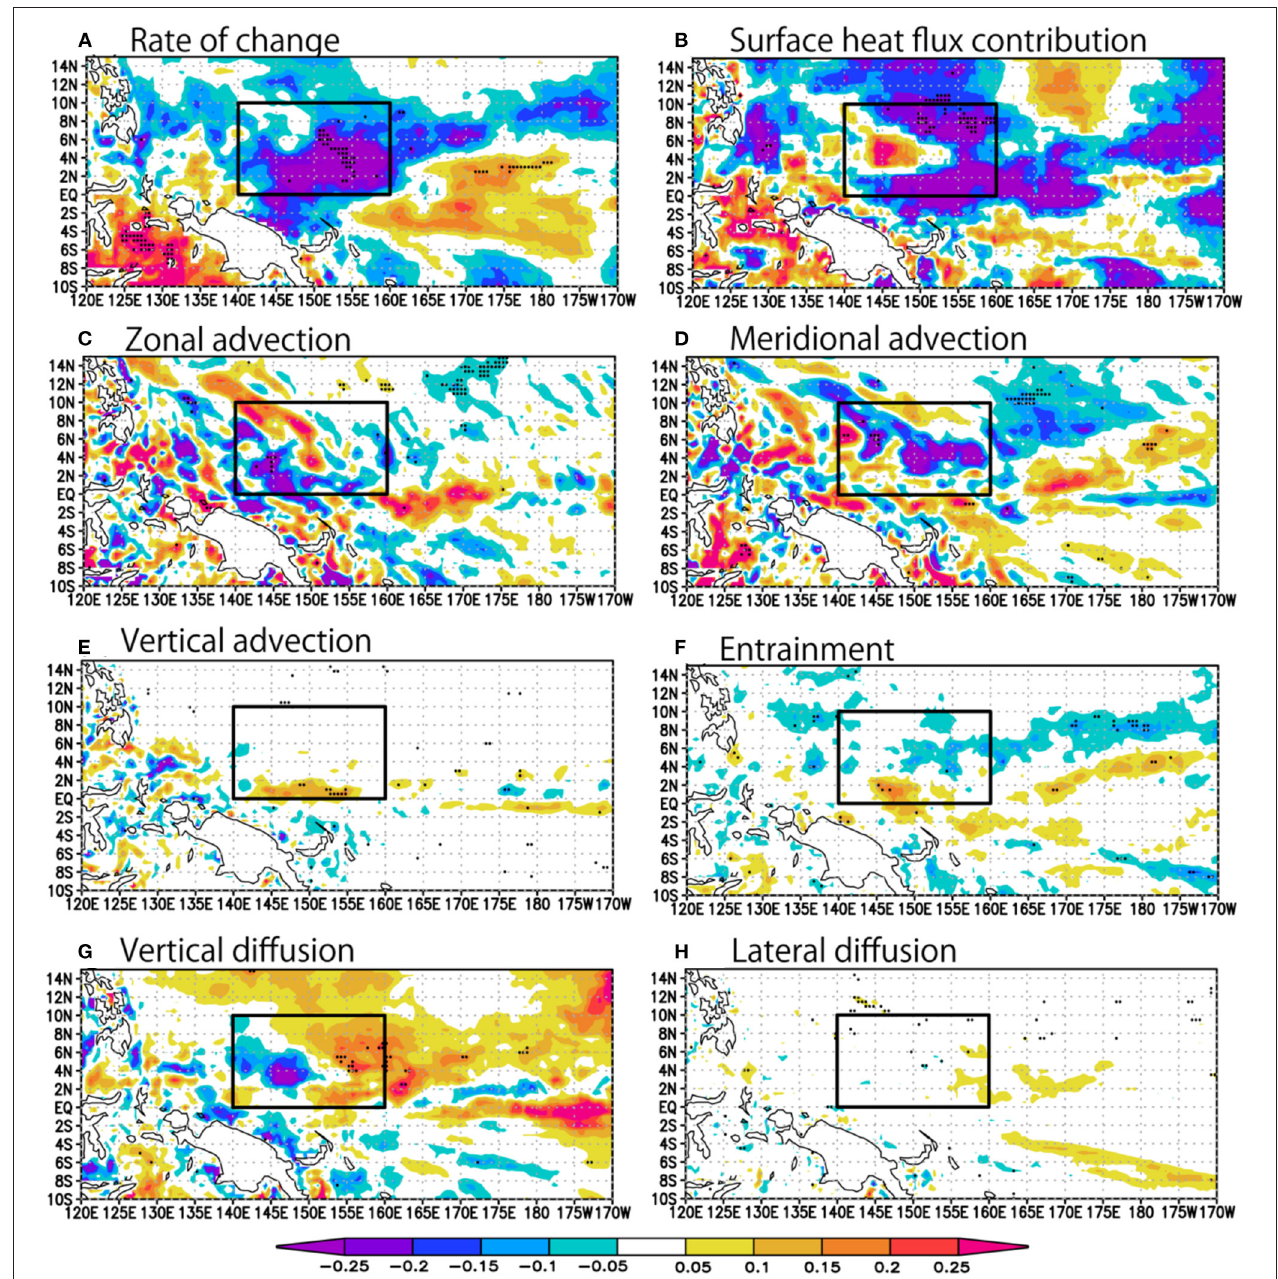
FIGURE 6 | Differences in the mixed-layer heat budget analysis ( ◦ C/30days) averaged in March 15, 2015–April 30, 2015 of the ensemble mean predictions (F2chT minus F2) (A) Total rate of change. Black dots indicate the statistically significant difference in the ensemble means between F2 and F2chT beyond the 90% confidence levels on paired t -test. (B–H) Contributions from the surface heat flux, zonal advection, meridional advection, vertical advection, entrainment, vertical diffusion, and lateral diffusion,